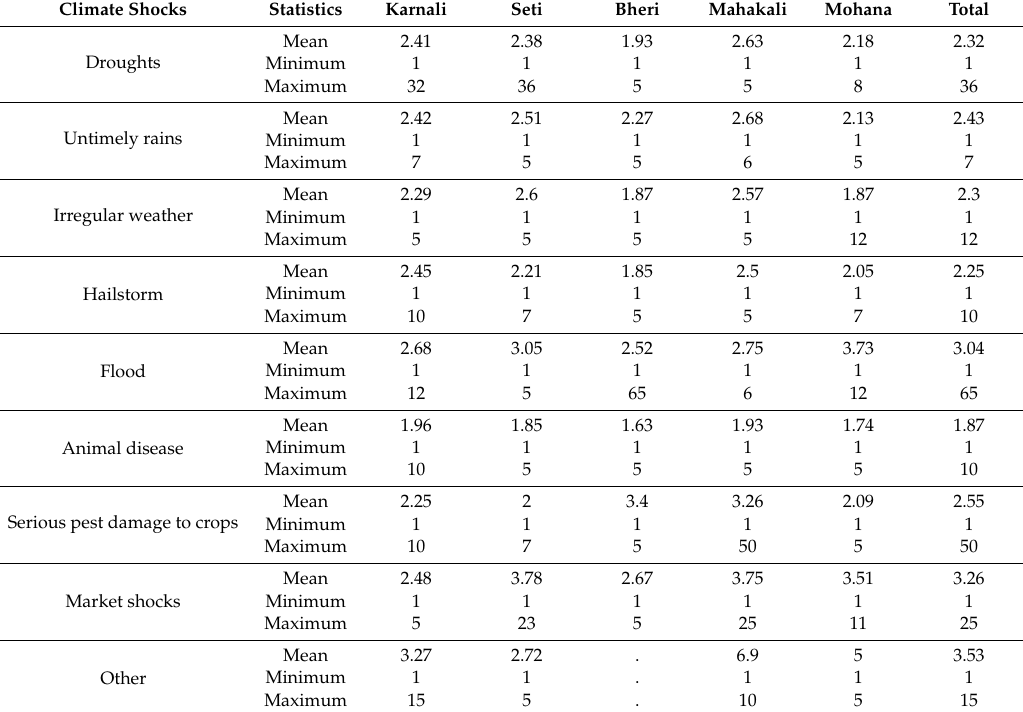
Table A3. Frequency of climate shocks across the sub-basins.